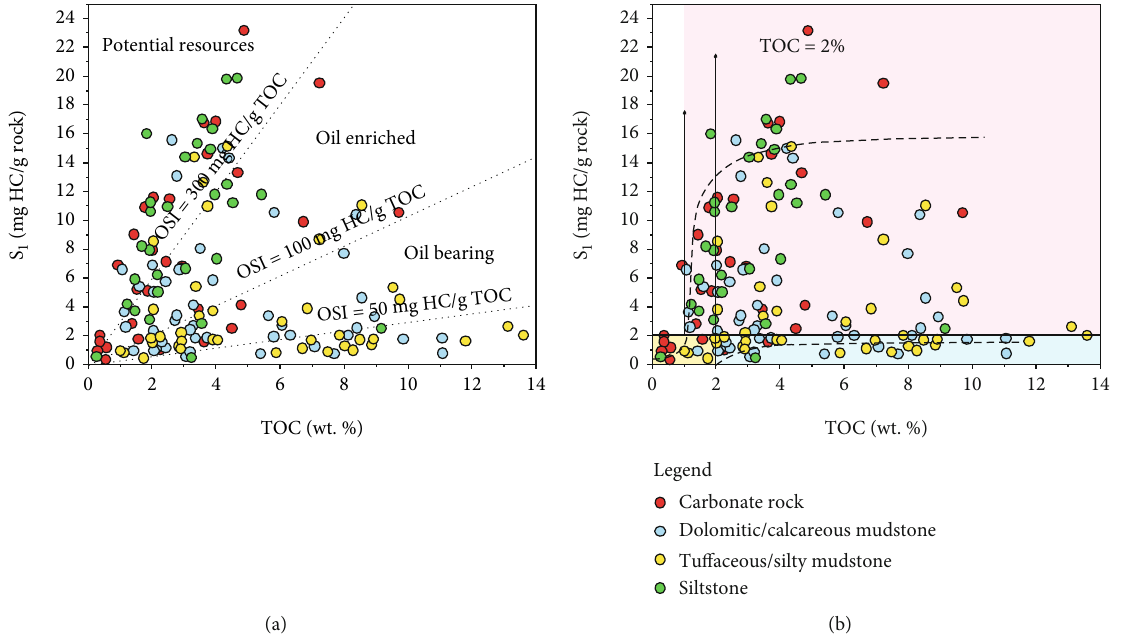
Figure 9: Shale oil potential of di ff erent lithofacies in the Lucaogou Formation, Jimusar Sag. (a) S OSI ranges for the di ff erent lithofacies. (b) Classi fi cation of the shale oil resource